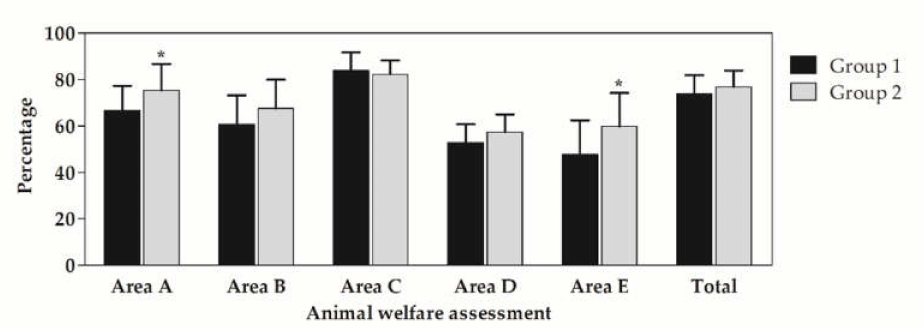
Figure 1. Mean ± standard deviations ( ± SD) of animal welfare assessment areas (Area A—“Farm management and personnel”; Area B—“Facilities and equipment”; Area C—“Animal-based mea-